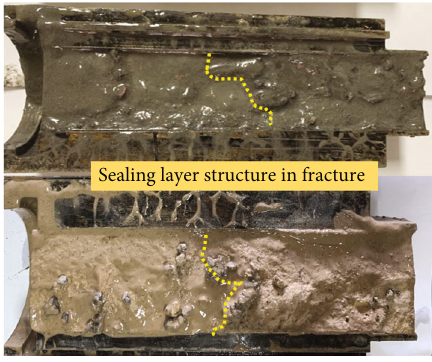
Sealing layer structure in fracture